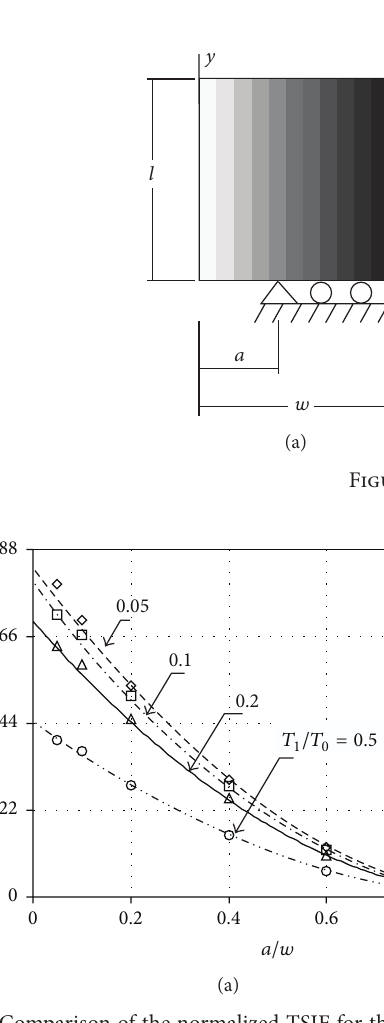
Figure 7: Comparison of the normalized TSIF for the cracked FGM plate under thermal loading: (a) 𝑇 1 = 𝑇 2 = 𝑇 and 𝑇 < 𝑇 0 ; and (b) = 0.5𝑇 𝑇 2 0 .